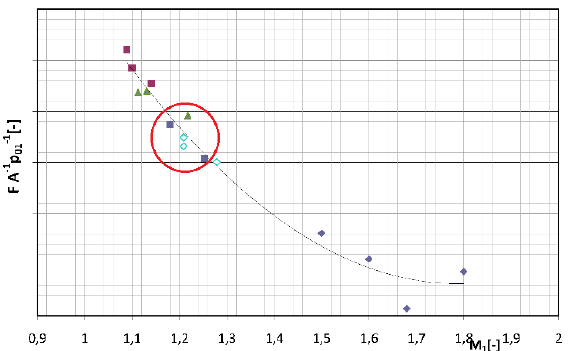
Figure 7. Distribution of dimensionless tangential force on the blade, points in the circle correspond to Figure 5.